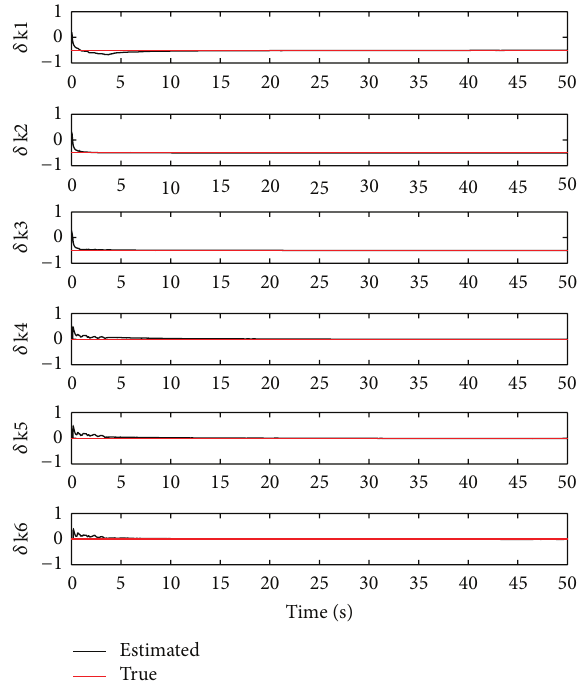
Figure 7: Unknown inputs estimation using the RTSKF. Figure 8: Damage stiffness estimation using the RTSKF ( 𝜖 = 1.5 ).